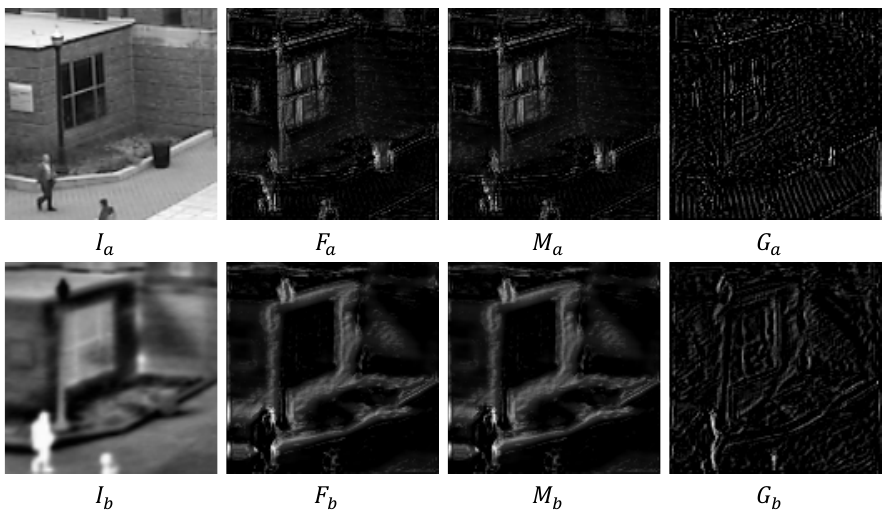
Figure 6. The network outputs of the feature extraction block, feature refinement block, and feature integration block are visualized on a synthetic benchmark dataset, respectively. Column 1 represents the input image to the network. Column 2 represents the multi-channel feature map visualization results output by the feature extraction block. Column 3 represents the visualization of the refined feature map output by the feature refinement block. Column 4 represents the visualization result of the integrated refined feature map output by the feature integration block.